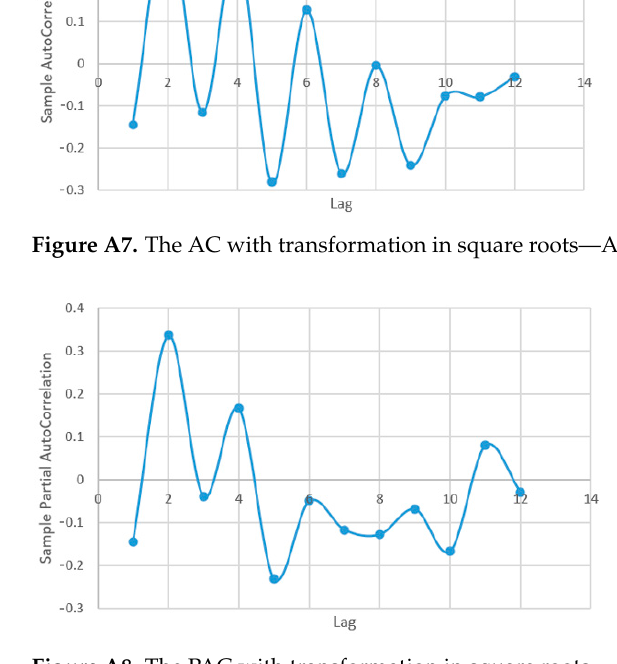
Figure A8. The PAC with transformation in square roots—AR series.